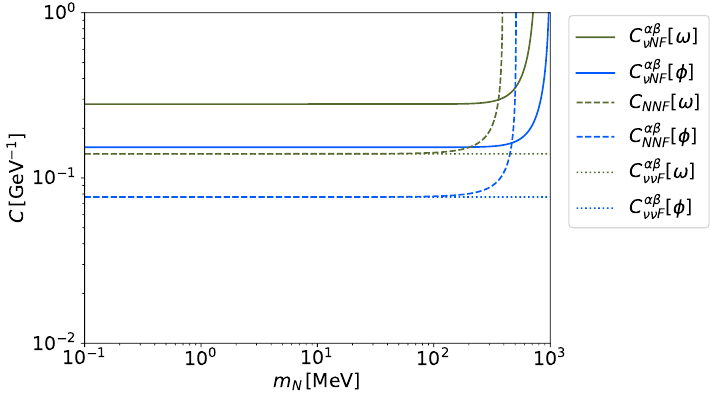
Figure 1 . The upper bounds on the LNEFT Wilson coe(cid:14)cients of dipole operators from meson invisible decays as a function of the RH neutrino mass m N